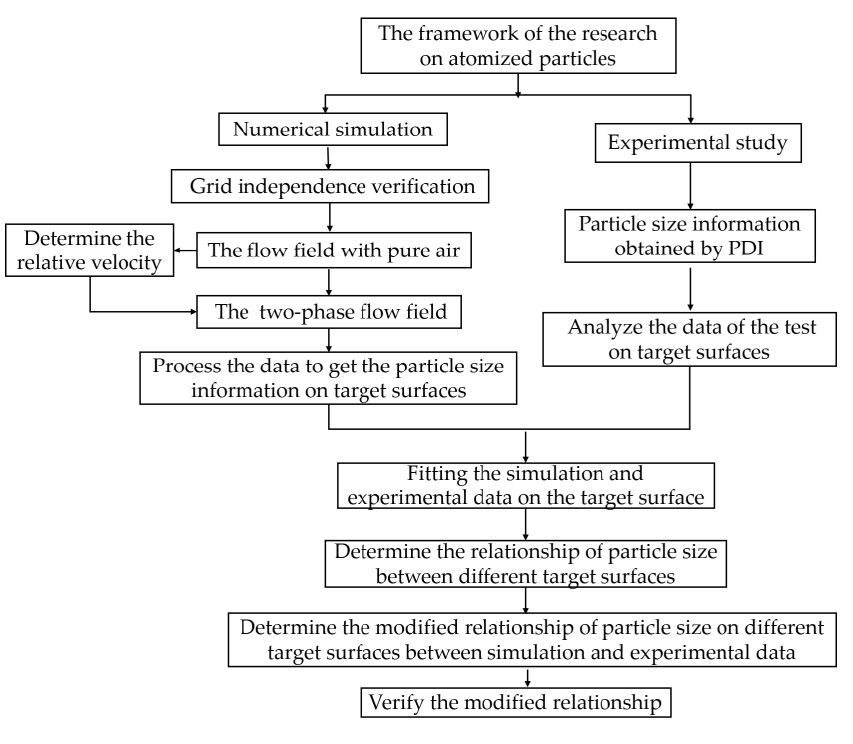
Figure 1. The framework of the research.